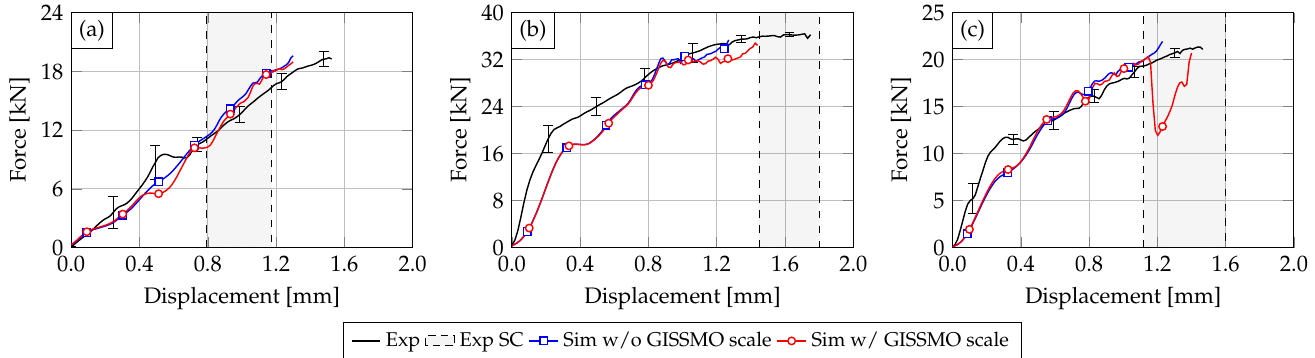
Figure 12. Comparison of the experimental (solid black curve) and numerical results without strain rate scaling GISSMO parameters (solid blue curve) and with strain rate scaling (solid red curve) for the PA12 busbars with impactor V1 ( a ), V4 ( b ) and V5 ( c ). The experimental electrical SR ranges are also